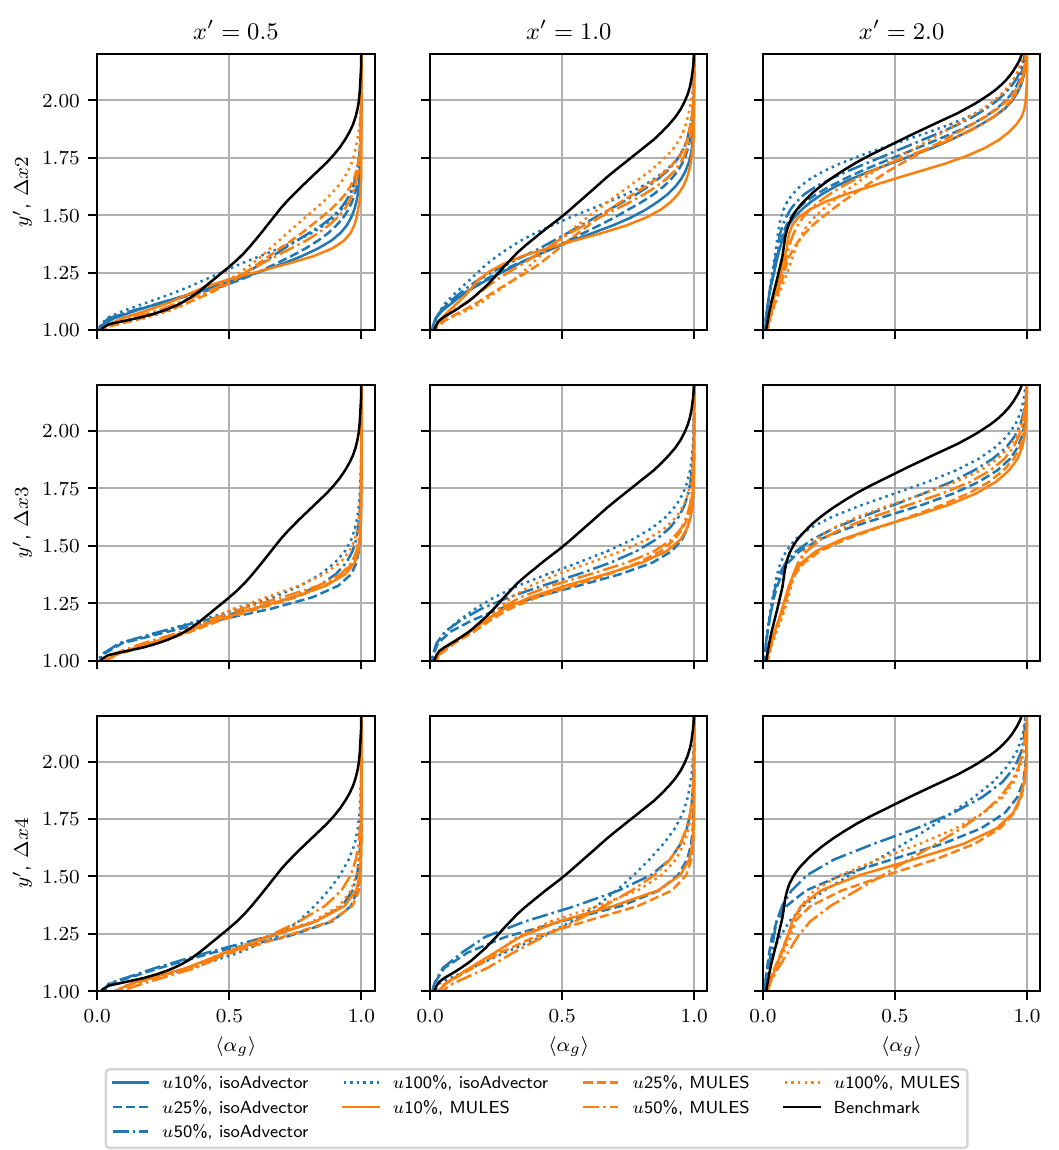
Figure 11. The profiles of (cid:104) α (cid:105) obtained in the simulation campaign. Figure 13 shows the obtained profiles of (cid:104) k (cid:105) . The observed error patterns were sig- nificantly less regular than in (cid:104) u (cid:105) and (cid:104) α (cid:105) . Two factors contributed to this. One is that (cid:104) k (cid:105) lumped together the errors in the variances of the three velocity components. The other was that parasitic oscillations had a direct amplifying effect on (cid:104) k (cid:105) . Both of the above can lead to either error cancellation or amplification. On the ∆ x 2 grid, the best results were achieved with isoAdvector and 25/50% upwinding. In the case of u 100%, the main peak in the detached shear layer was somewhat under-predicted, but the discrepancy was not very significant. An interesting observation is that at lower grid resolutions, a secondary peak in (cid:104) k (cid:105) was developed for x (cid:48) = 1.0 and 2.0 right underneath the interface. This unphysical peak was more pronounced when isoAdvector was used and could even be observed on the ∆ x 2 grid when this interface-capturing technique was used. It was present in all three components of the velocity variance, although for the streamwise component, it was less pronounced. The size of the peak grew with a decreasing amount of upwinding, which confirmed its numerical origin. Even apart from this additional peak, the results for (cid:104) k (cid:105) on ∆ x 3 and ∆ x 4 were quite inaccurate, although the combination ∆ x 4, u 50%, and MULES reproduced the main features of the benchmark profiles fairly